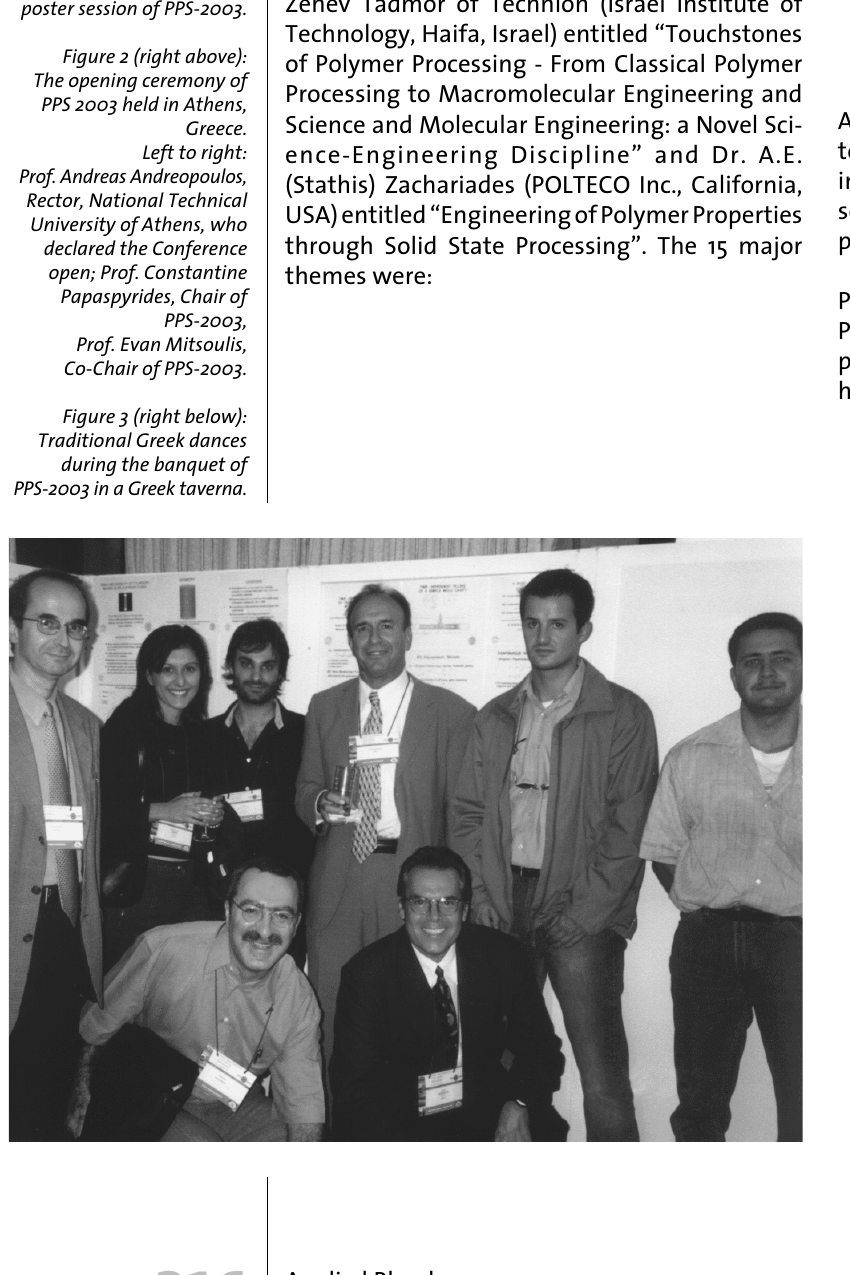
Figure 1 (left): Delegates (including Professors and their students) during the poster session of PPS-2003. Figure 2 (right above): The opening ceremony of PPS 2003 held in Athens, Greece.